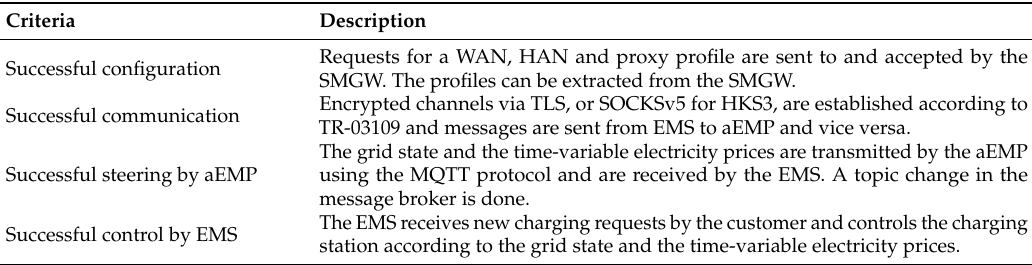
Table 2. Criteria determining whether the prototype works as